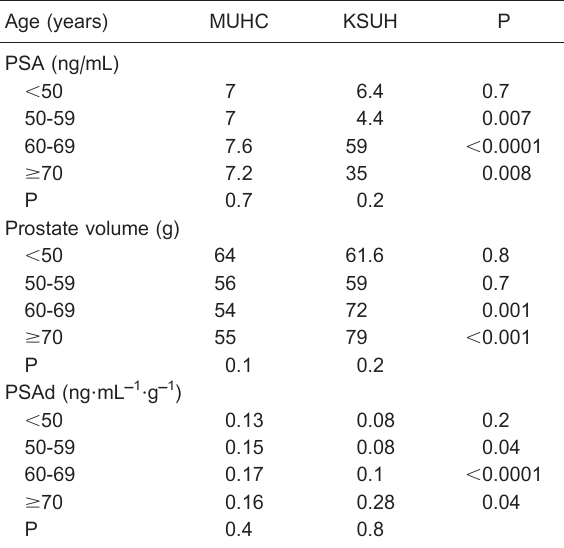
Table 2. Age-associated changes in PSA level, prostate volume, and PSAd in the MUHC and KSUH groups. Age (years)